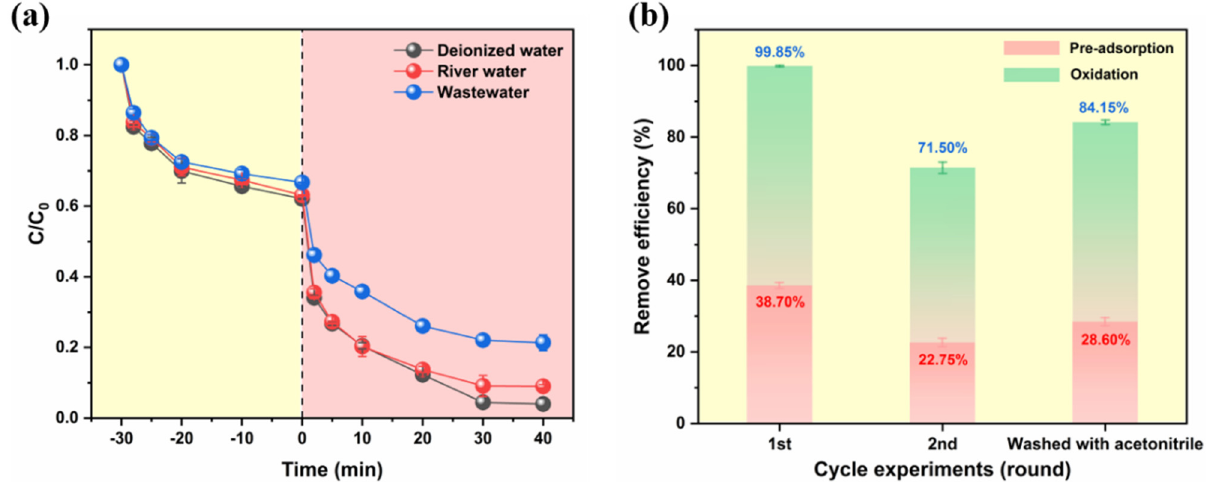
Figure 10. Elimination of SDZ in real aquatic systems ( a ) and the regeneration of ASBC800 ( b ).